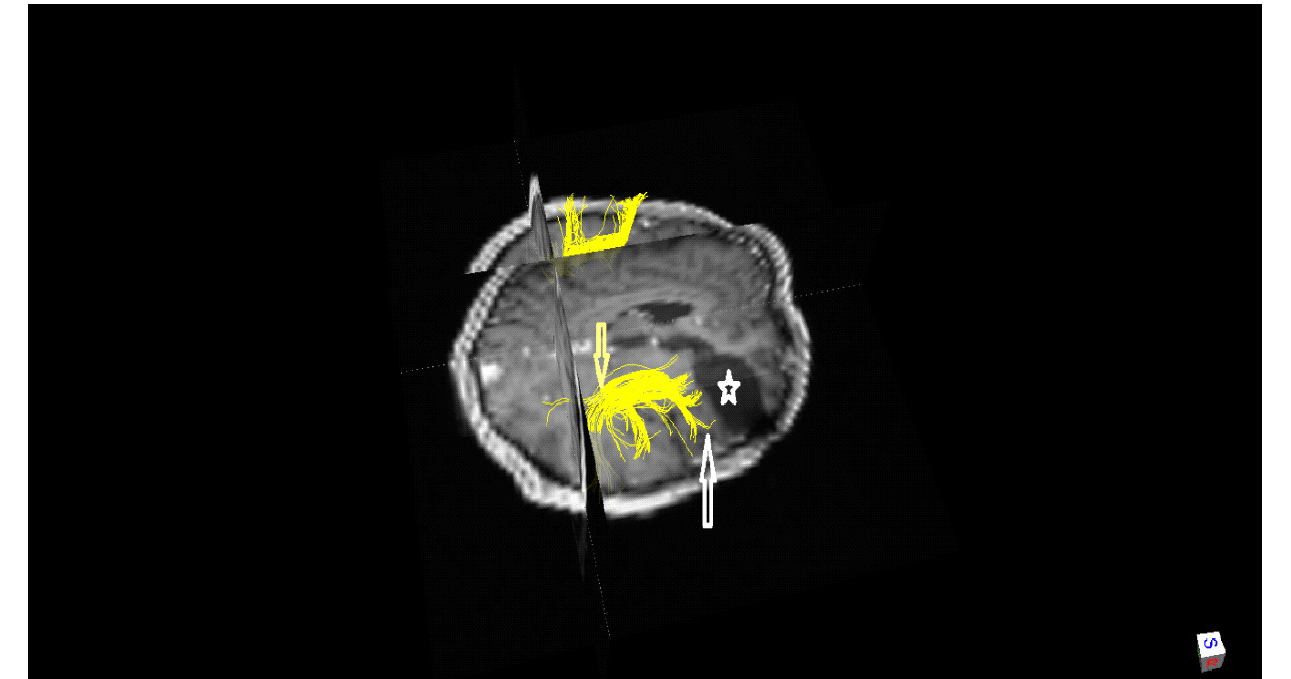
Figure 2. Magnetic Resonance Imaging (MRI) with diffusion tensor imaging (DTI) technique and fibre tracking (January 2015) revealed right arcuate fasciculi (yellow arrow). It also showed the an ‐ terior end of right arcuate fasciculus (white arrow), which is distant from the rear wall of the oper ‐ ative cavity (white star).